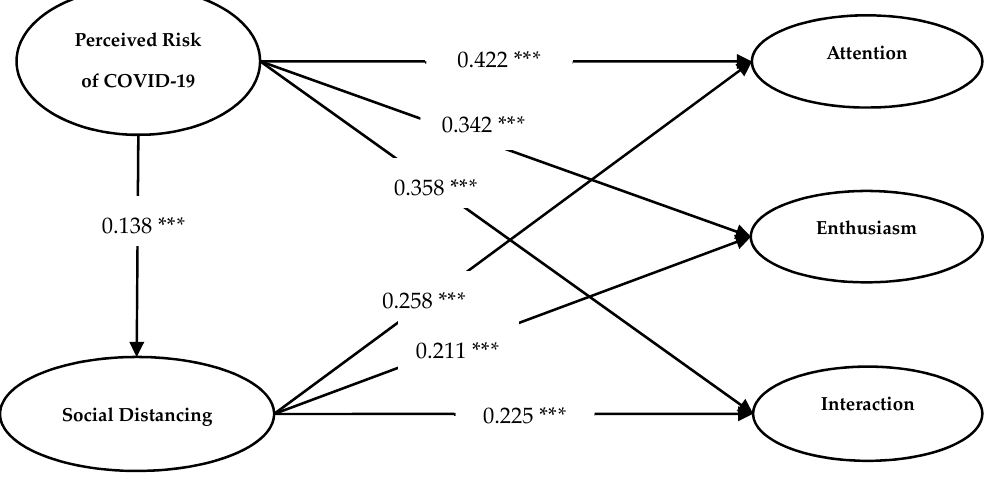
Figure 2. Results of the SEM. *** p < 0.001.